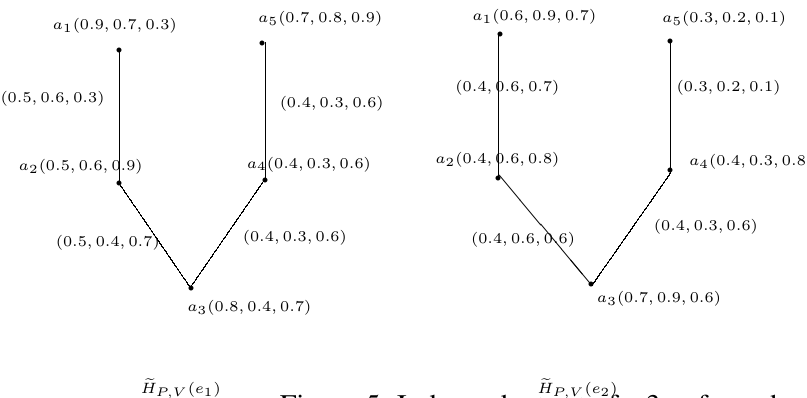
Figure.5. Independent set of a